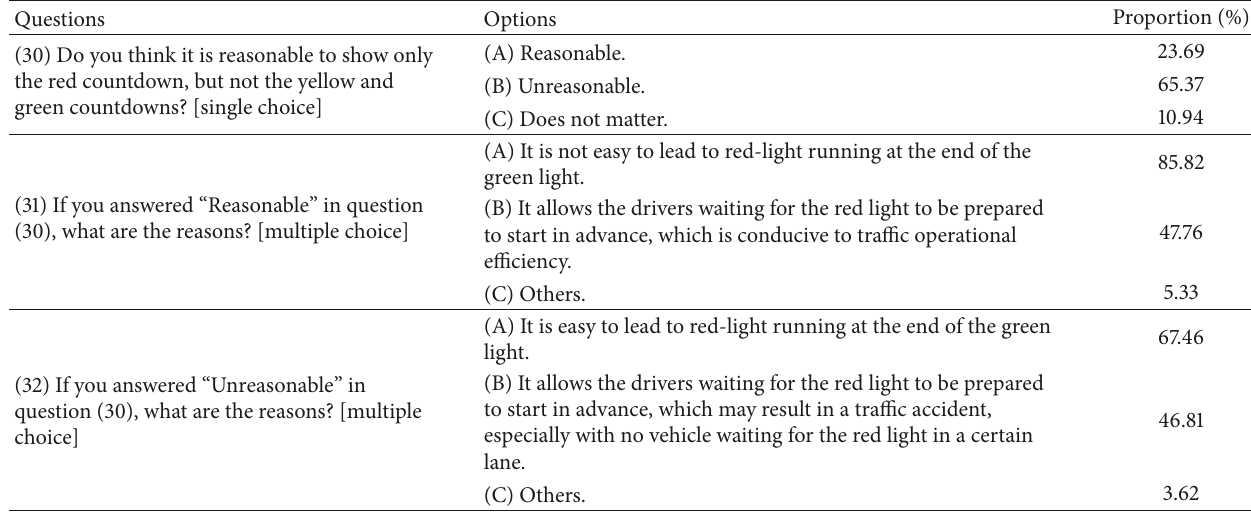
Table 11: Attitudes and understanding of surveyed drivers on the display modes of countdown signals.